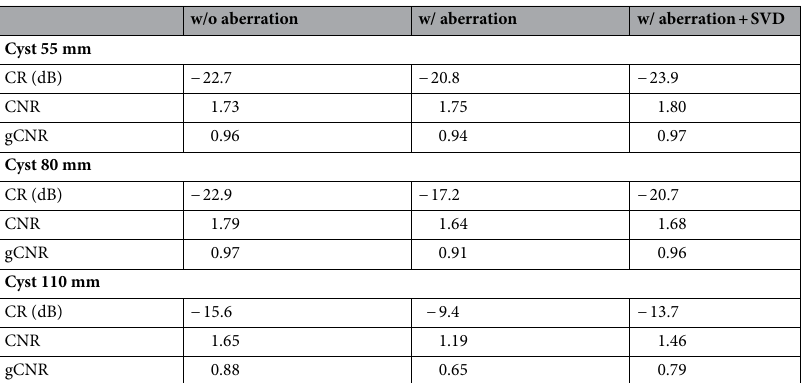
Table 2. Evaluation of contrast ratio (CR), contrast-to-noise ratio (CNR) and generalized contrast-to-noise ratio (gCNR) in the presence of aberrations on the commercial phantom. Quantification is done on cyst- like structures at depths of 55, 80 and 110 mm for 91 PWs (− 30° to 30°). Aberrations are introduced by a layer of water/ethanol solution with a speed of sound of 1450 m/s between the arrays and the CIRS phantom (1540